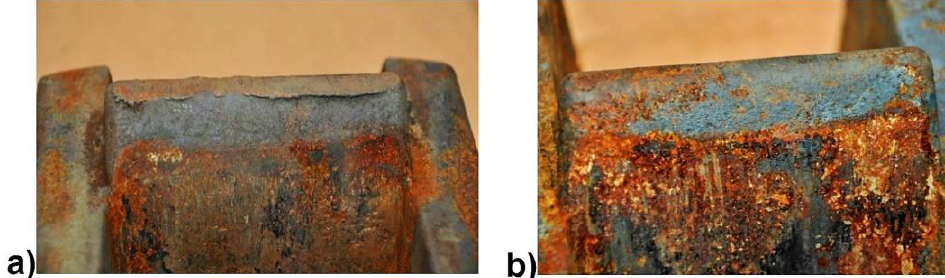
Figure 11. View of the top surface tooth of the Komtrack toothed segment: ( a ) damaged, ( b ) without any signs of damage.